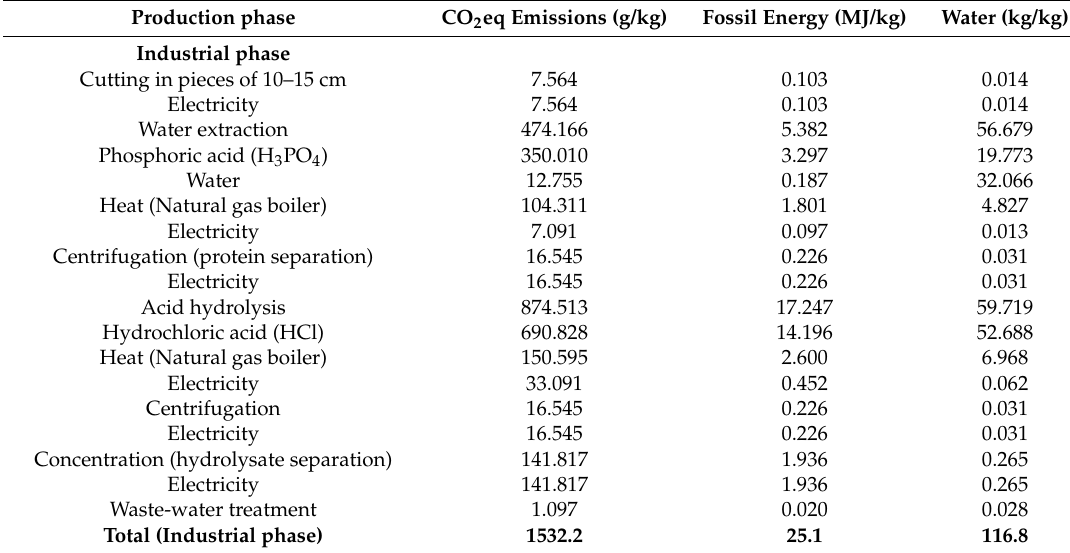
Table 6. LCA results for protein hydrolysate production from leather wastes (data refer to the production of 1 kg protein hydrolysate).